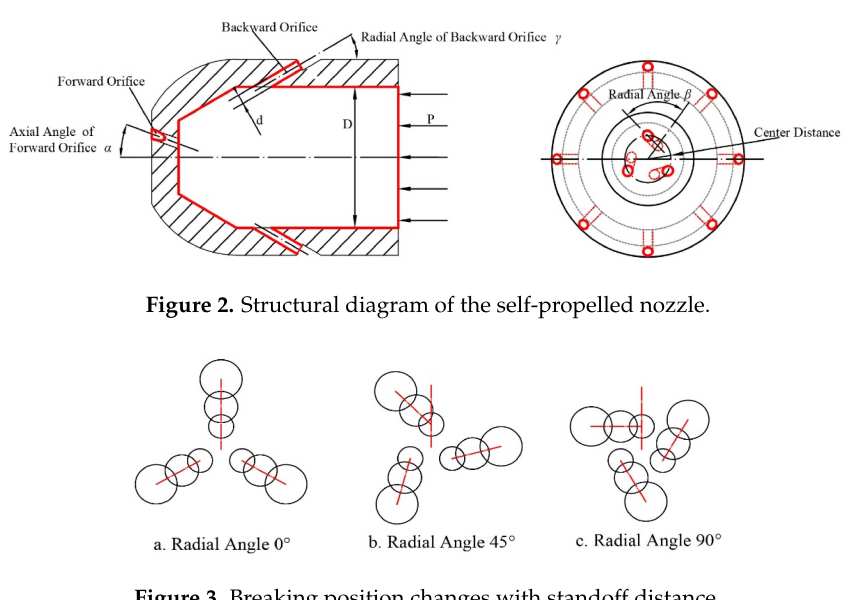
Figure 3. Breaking position changes with standoff